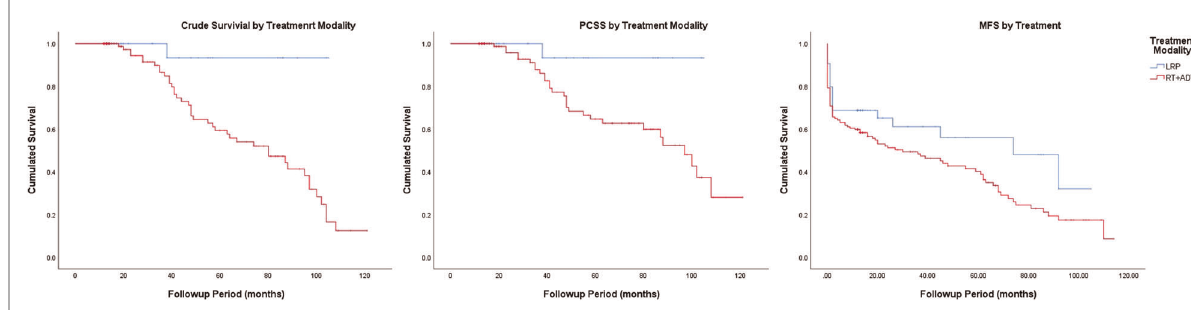
FIGURE 1 Crude survival, prostate cancer-speci fi c survival and metastasis-free survival by treatment modality.